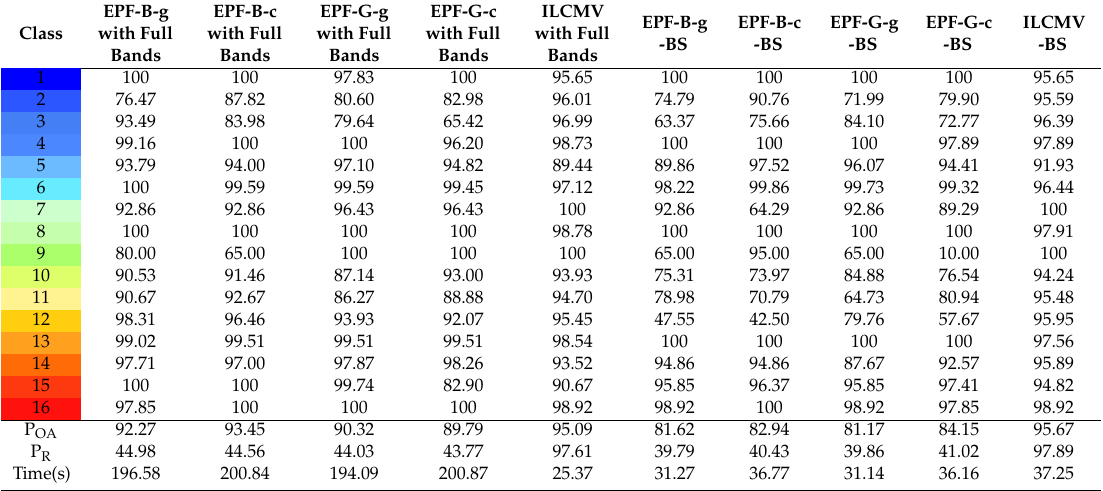
Table 7. P OA and P R calculated by the classification results using the bands selected by SQ LCMV-BSS-1 for the Purdue